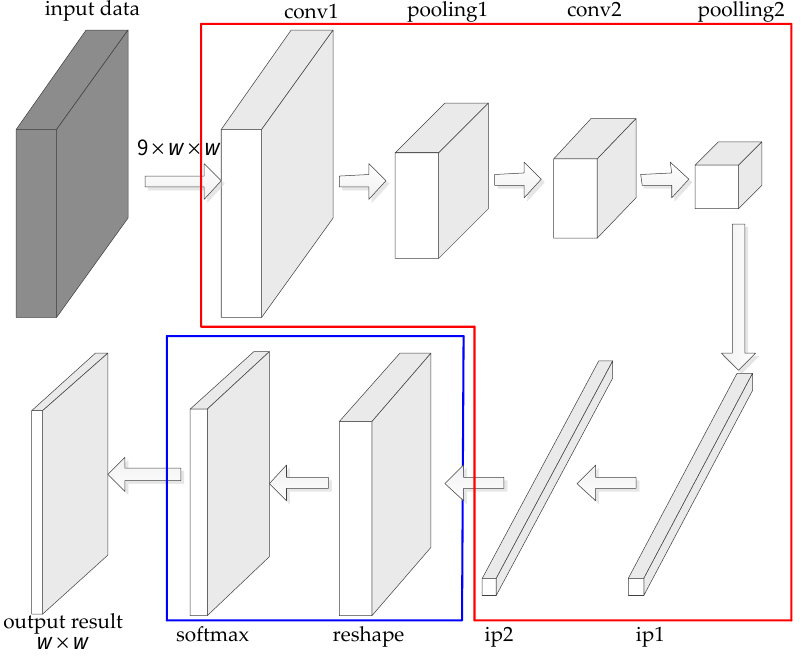
Figure 11. Decreased-feature-size